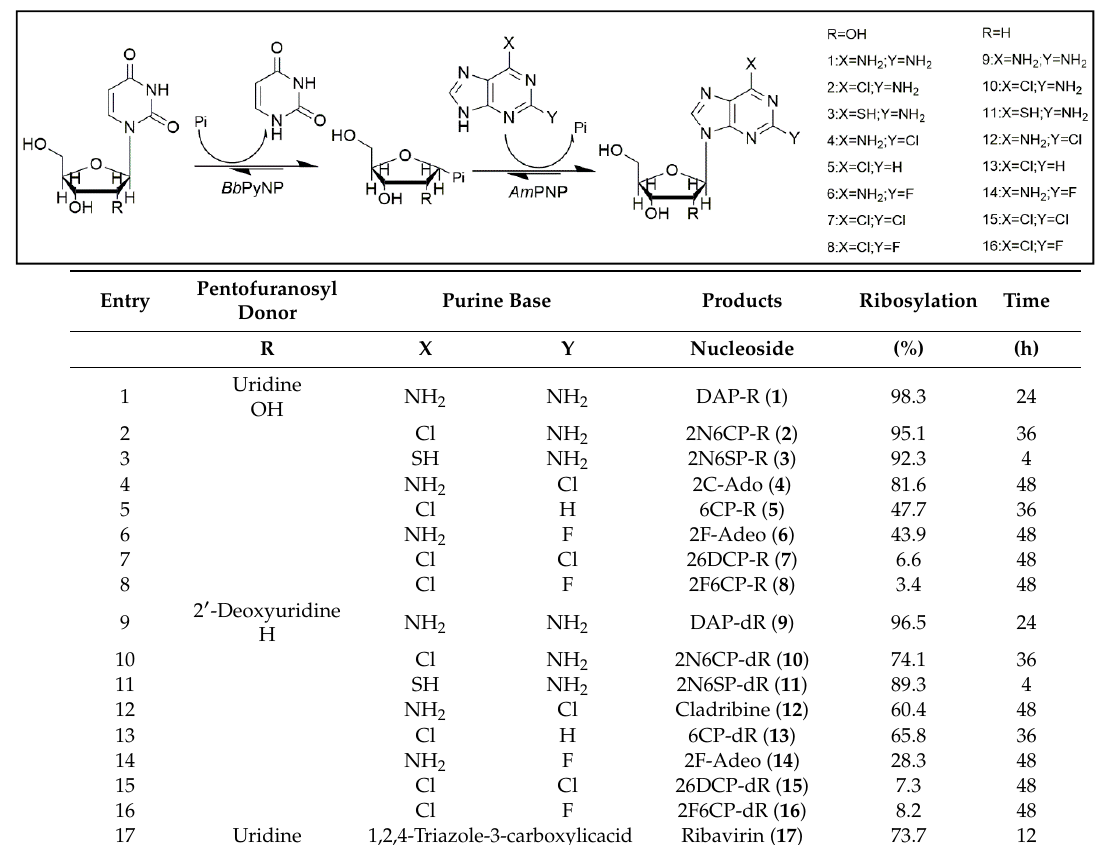
Table 3. Biosynthesis of purine nucleoside analogs.